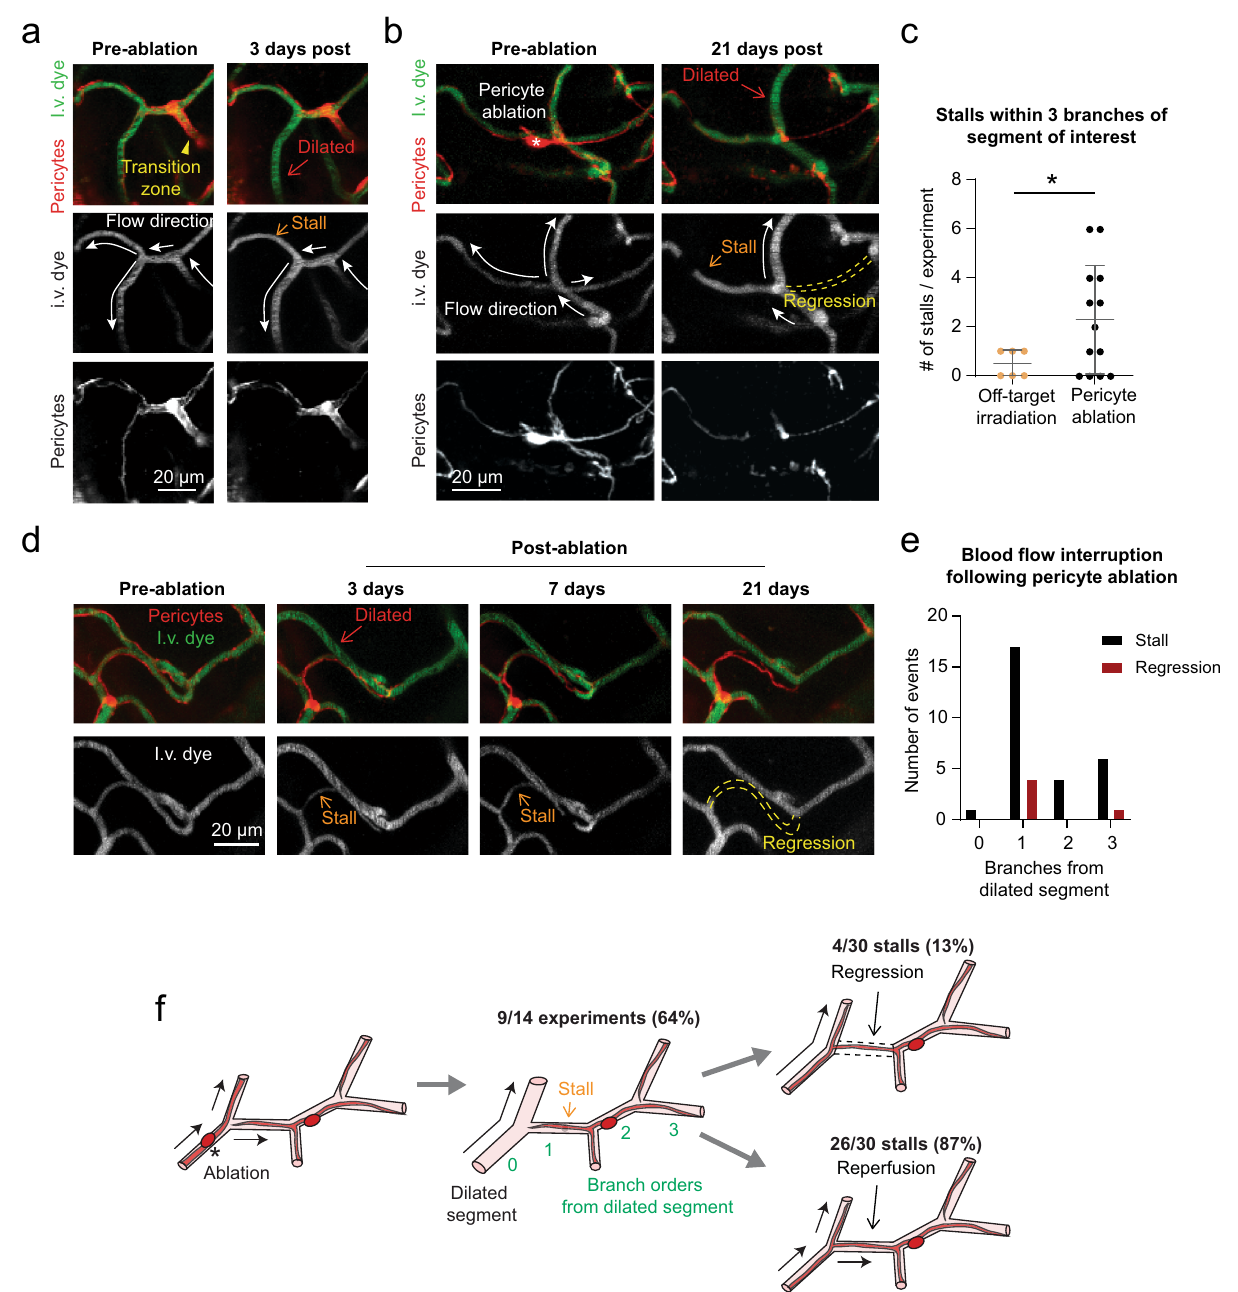
Fig. 9 | Blood fl ow stalls and regression in capillaries neighboring dilation. a A divergentbifurcationclosetothearteriole-capillarytransitionzone.Onebranchof the bifurcation is dilated from pericyte loss 3 days post-ablation, and the resulting re-direction of fl ow creates a stall in the alternate, covered branch. Images are representativeexamplesfrom14ablationexperimentsacrossadultandagedmice. I.v. dye = intravenous dye. b Example of blood fl ow defects at a capillary junction near the arteriole-capillary transition zone. At 21 days post-ablation, a central capillaryisuncovered,dilated,and fl owing.Theotherbrancheshavestalledin fl ow or regressed. c Occurrence of stalls in triple off-target sham irradiation and triple